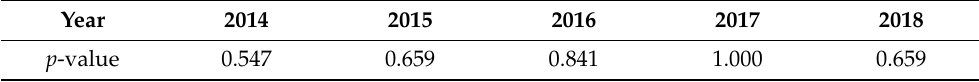
Table 7. Mann-Whitney U test of the urban and non-urban health efficiency